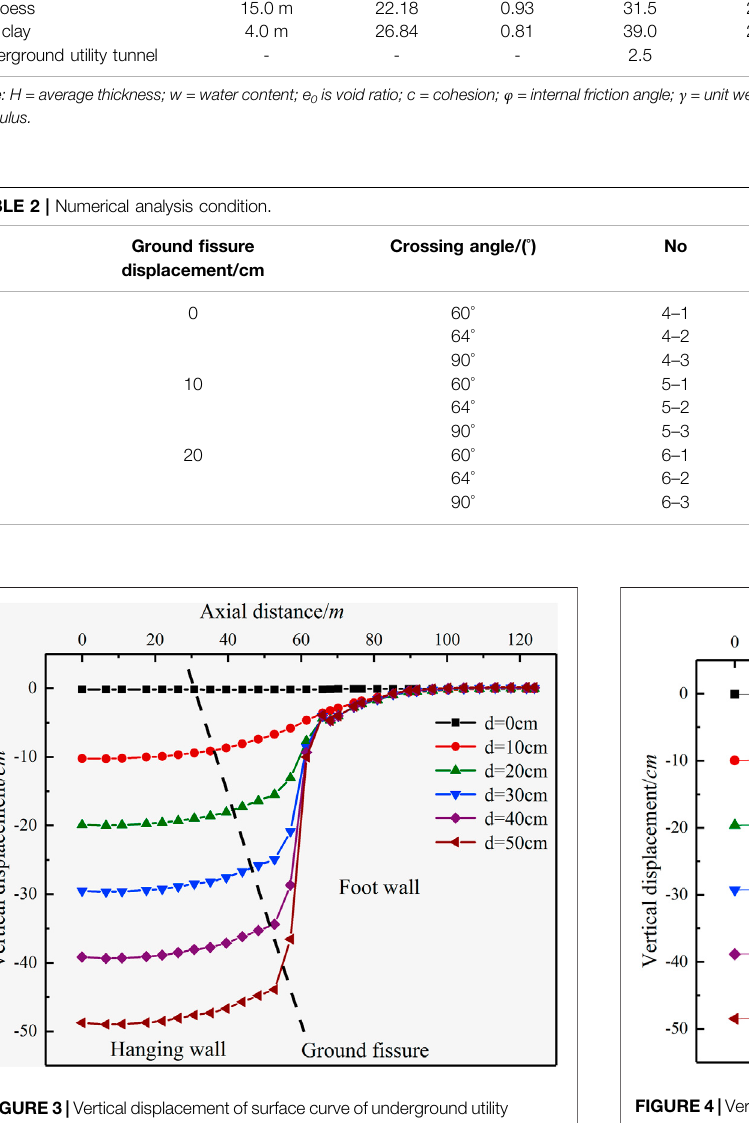
Frontiers in Earth Science |